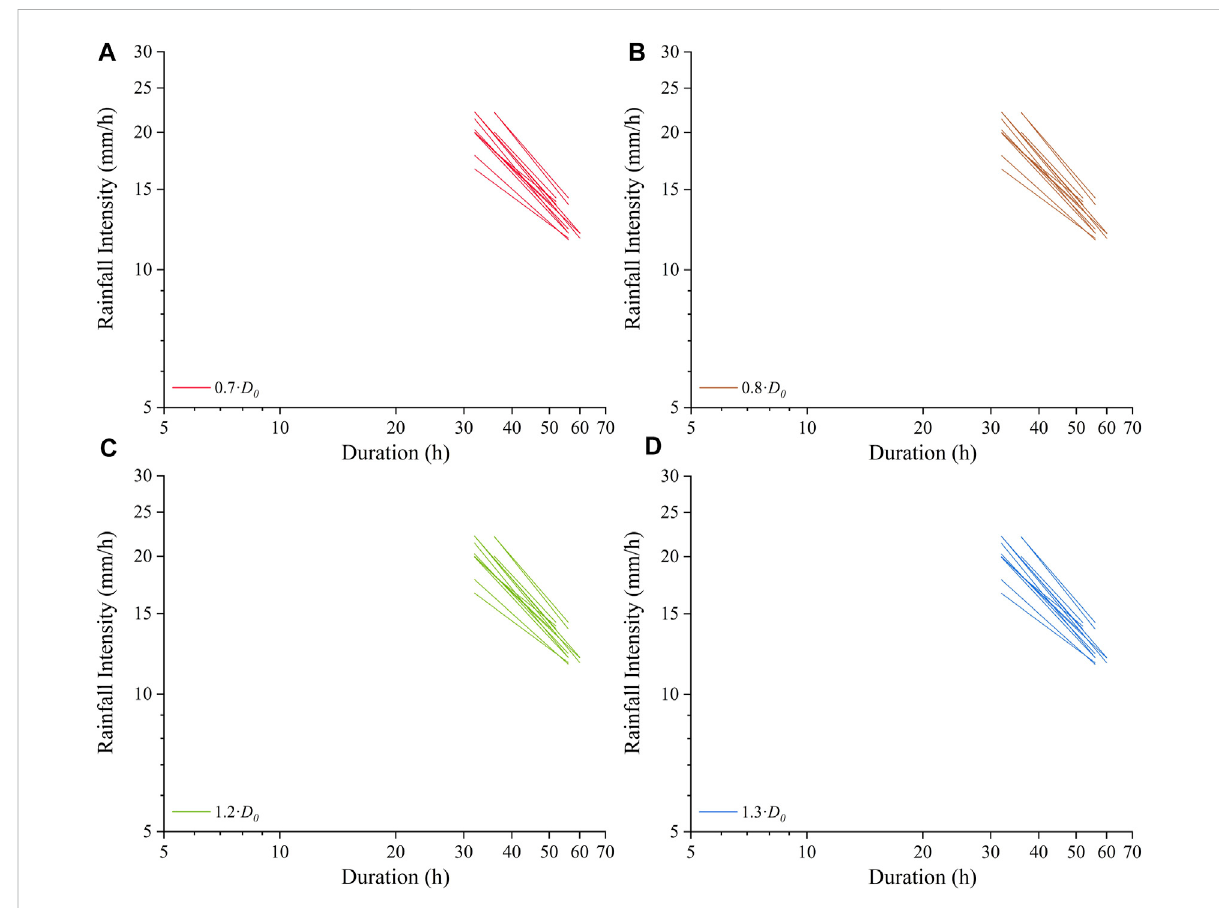
FIGURE 9 I-D thresholds de fi ned at the slope unit scale under the conditions: (A) 0.8 · D